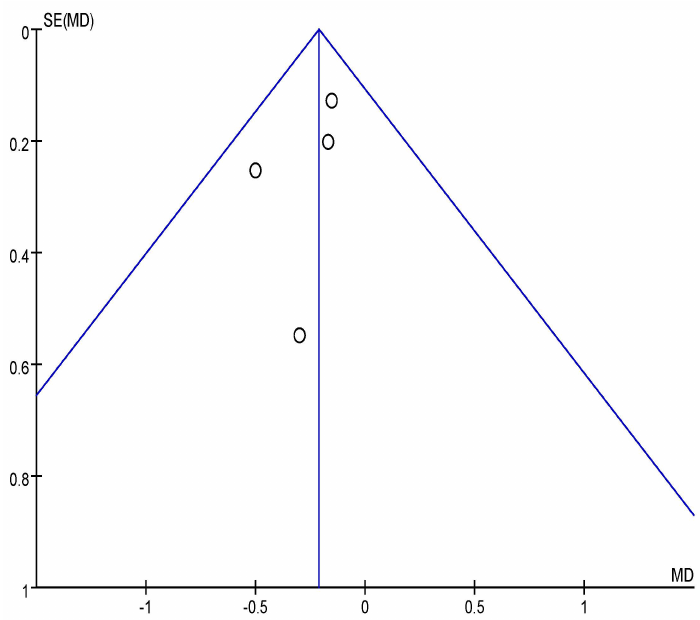
Figure 5. Funnel plot for the effect of OBG intake on HbA 1c (%). For Ma 2013 [15], HbA 1c (%) is obtained at a dose of 2.5 g/day OBG.